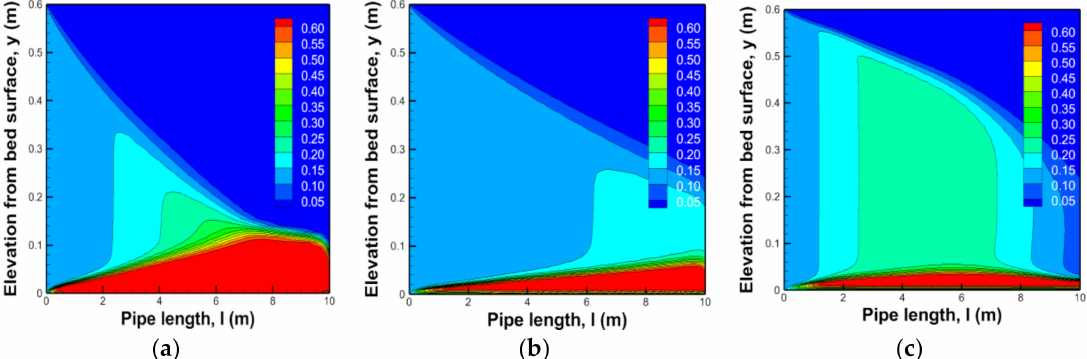
Figure 8. Sedimentation results for soil of diameter 1.0 mm according to changes in inlet velocity.